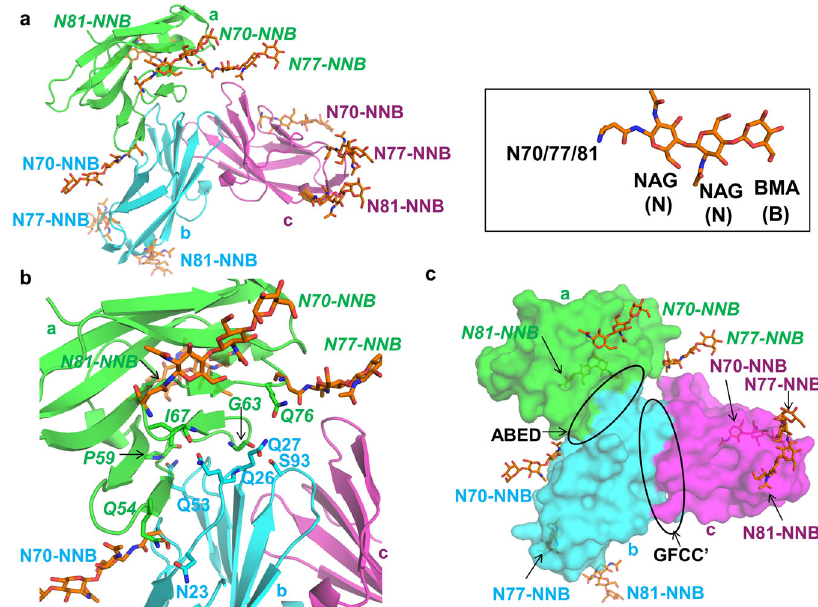
Fig. 2 Glycosylated model of the hCEACAM1. a Modeling of the N-linked sugars N-acetylglucosamine (NAG) and β -d-Mannose (BMA) onto the N70, N77, and N81 residues of all three human CEACAM1 molecules observed in the crystal structure, wherein hCEACAM1 molecules (a in green, b in cyan, and c in magenta) are shown by ribbon diagram. Right inset shows structure of two N-acetylglucosamine (NAG) and one β -d-Mannose (BMA) by stick representation, which are modeled onto each set of N70, N77, and N81 residues in the crystal structure shown in left and abbreviated as NNB in the fi gure. For each sugar molecule, carbon atoms in orange, carbonyl oxygen in red and nitrogen in blue, are colored, respectively. Three sugars are shown for each hCEACAM1 molecule a, b and c (labelled in green, cyan and magenta, respectively). b Modeled N-linked sugars N-acetylglucosamine (NAG) and β -d- Mannose (BMA) onto the N70, N77, and N81 residues of human CEACAM1 molecules (a, b) do not appear to block any of the ABED face hydrogen-bond interactions shown. Modeled sugars are shown by stick diagrams and labeled as above. c Surface representation (green, cyan, and magenta) for molecules a, b, and c, respectively, and stick representation of modeled sugar molecules. GFCC ’ and ABED face interactions are depicted by black oblong and three modeled NNB sugars on each hCEACAM1 molecule residues N70, N77 and N81 do not appear to block ABED and GFCC ’ face interactions. NNB sugars and hCEACAM1 molecules are colored and labeled as